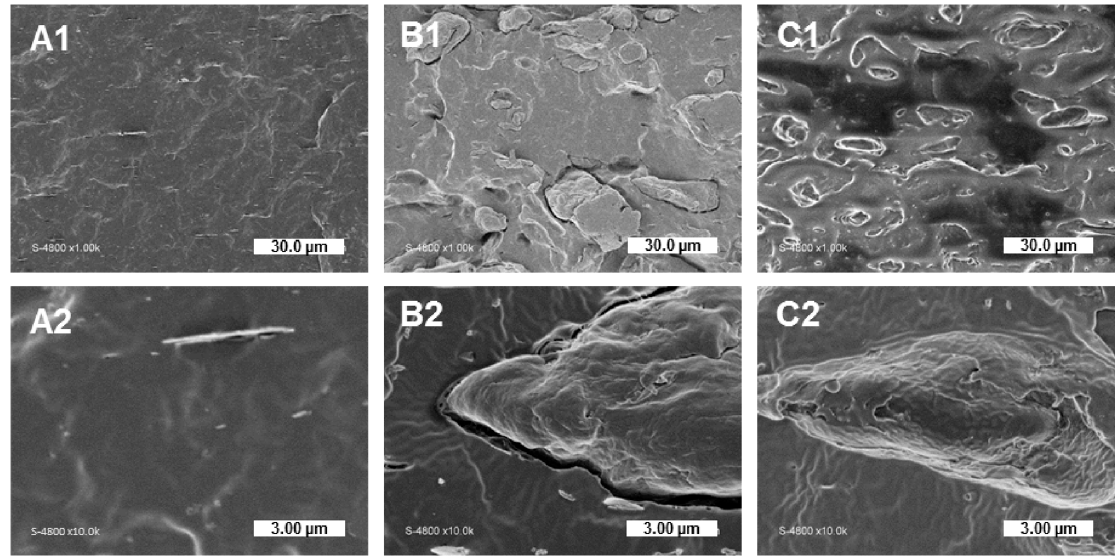
Figure 3. SEM pictures of cryo-fractured sections: ( A1 , A2 ) neat PHBV, ( B1 , B2 ) PHBV-20VC, and ( C1 , C2 ) PHBV-20CG. and ( C1 , C2 )